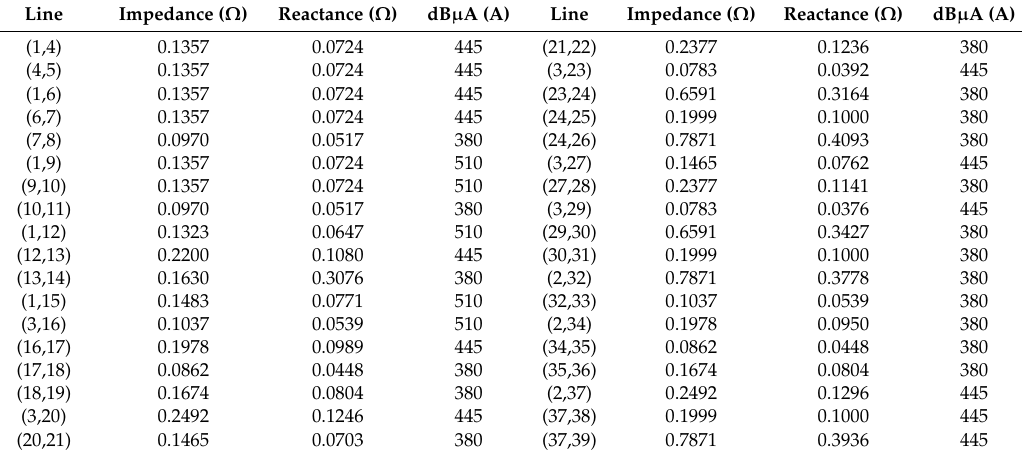
Table 5. The impedance and limitation of electric